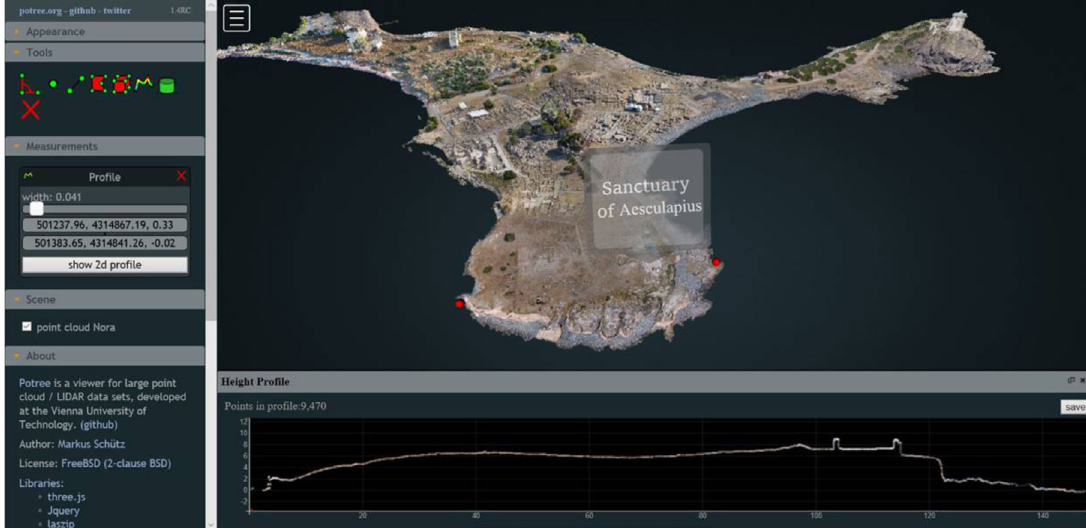
Figure 5. Potree’s interface. The web renderer shows the point cloud of the site, providing a toolbox for geometrical analyses of the model. One of these tools produces the profile along a cross-section, as shown on the bottom window. Labels on the point cloud semantically inform the